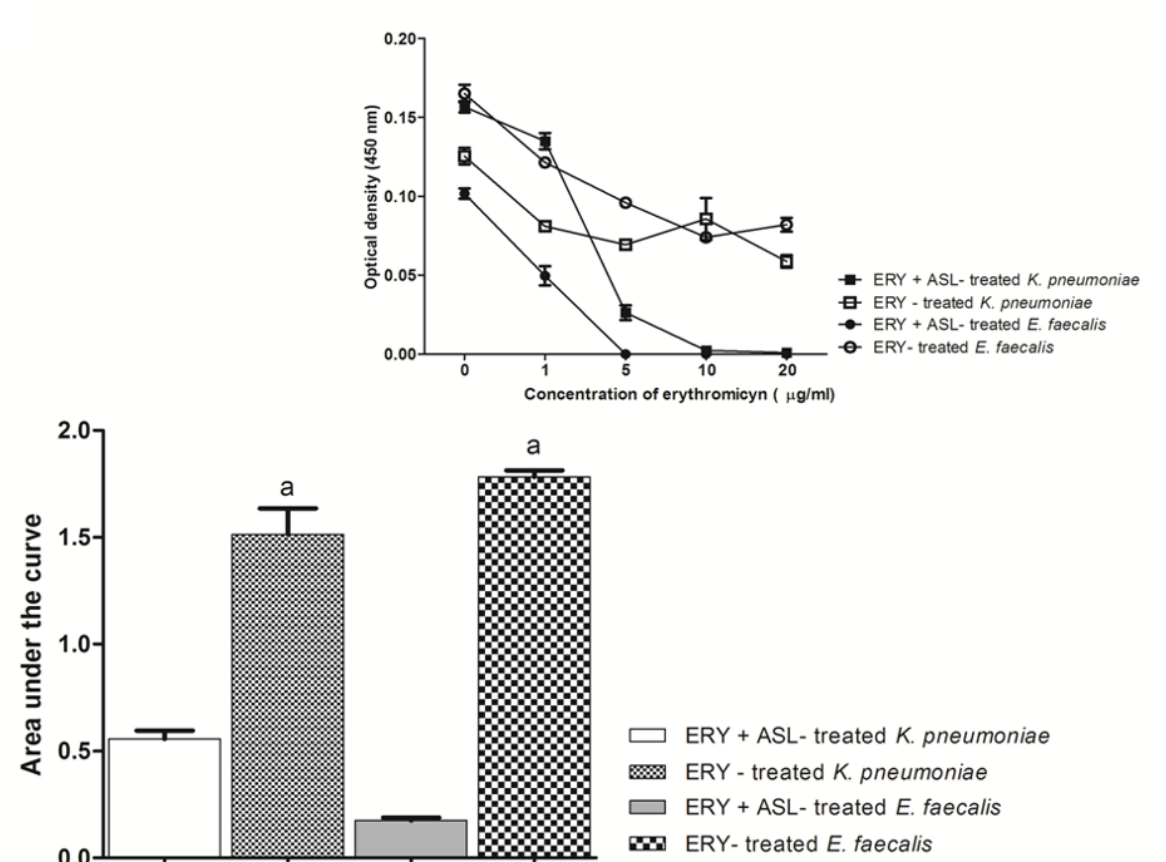
Figure 5 - Mode of action of methanolic extract of Annona squamosa leaves (ASL). Outer membrane permeability of K. pneumoniae and E. faecalis induced by ASL in association with erytromicin. a Statistically different from ERY + ASL treated. (ANOVA followed by Bonferroni, P < 0.05). All experiments were carried out in triplicate, and average values are reported. Error bars refer to the standard